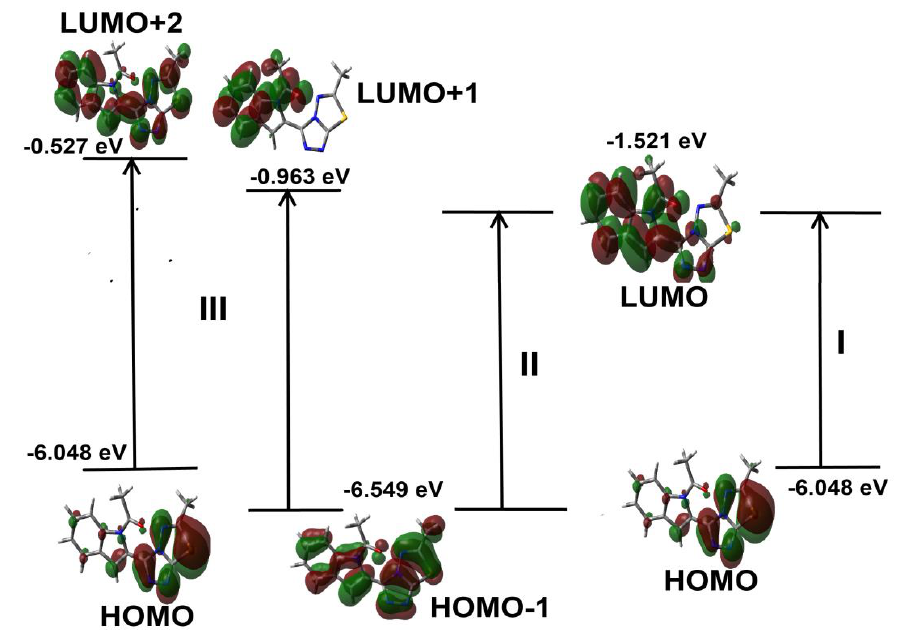
Figure 13. Presentation of the molecular orbitals included in the electronic transitions of the studied compound in ethanol as solvent. The definitions of I , II and III refer to Table 4.